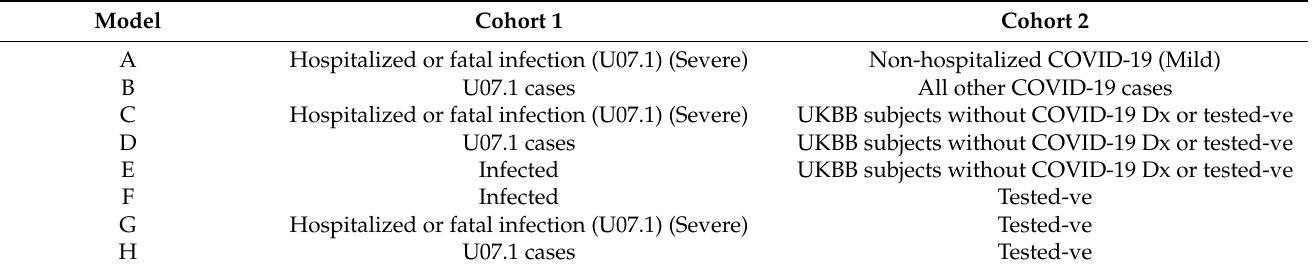
Table 1. The eight sets of analyses based on infected patients (model A, B), tested subjects (models F, G, H) and the population (models C, D,